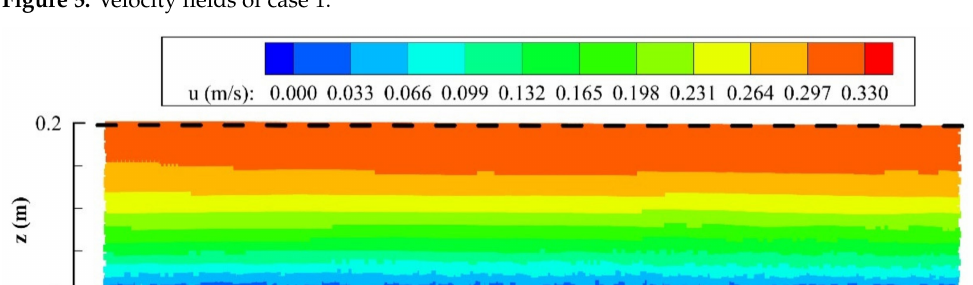
Figure 5. Velocity fields of case 1.